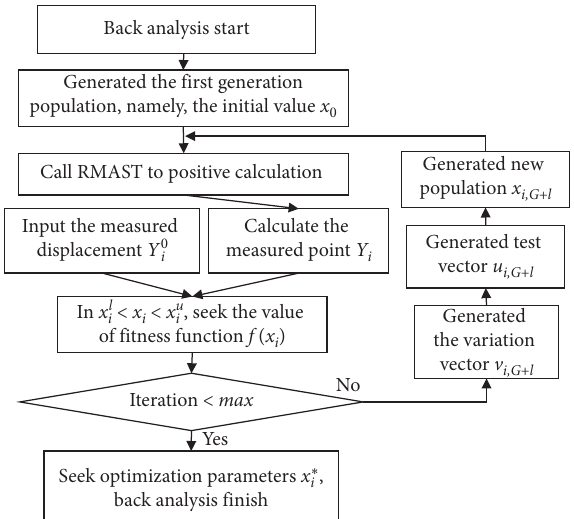
Figure 4: Calculation process of back analysis.